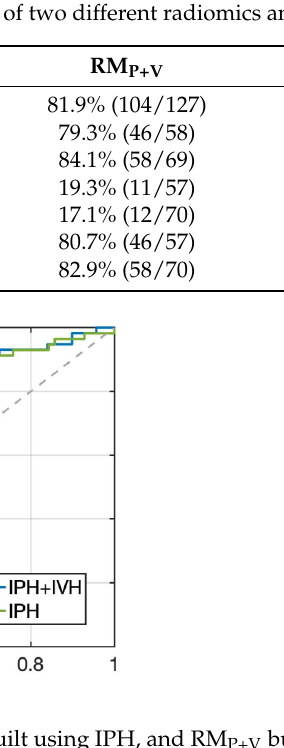
Figure 4. A case illustration. A 51-year-old male with right putaminal hemorrhage, classified as an expander based either on IPH or IPH + IVH criteria. The patient was discharged on Day-5 after ICH with a mRS of 6. The RM P based on ICH P wrongly predicted this case as a non-expander, but the RM P+V based on ICH P+V correctly predicted this case as an expander.